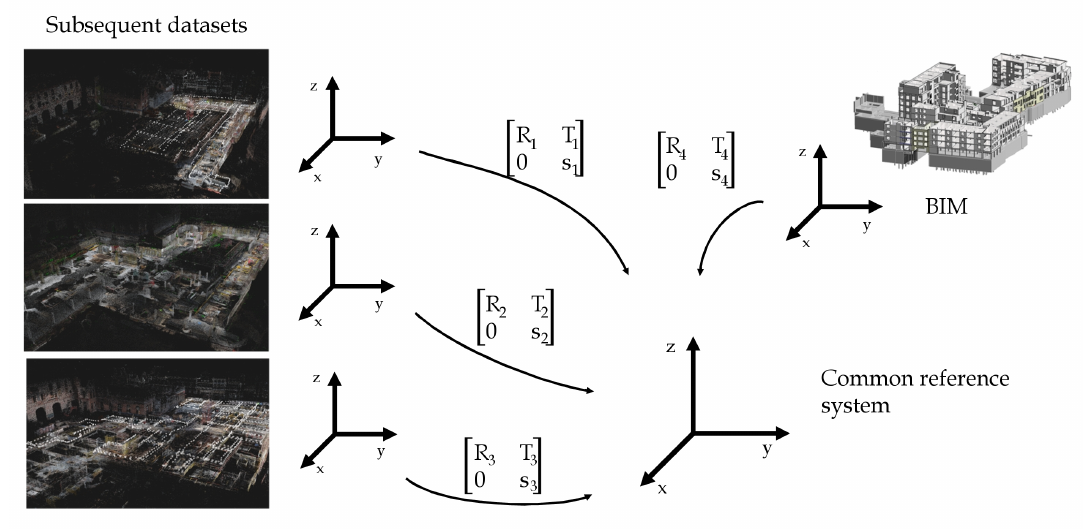
Figure 2. Each subsequent dataset ( left ) and the as-design Building Information Modelling (BIM) model itself ( right ) is processed or represented in its own coordinate system. For monitoring purposes it is crucial that different datasets share a common reference system. To this end, the registration process determines the unique transformation (consisting of translation (T), rotation (R) and scale (s) parameters) for each dataset.